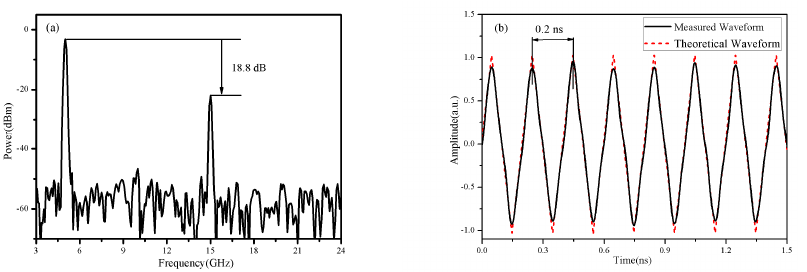
Figure 4. Measured ( a ) electrical power spectrum and ( b ) waveforms of the generated triangular pulse trains with a repetition rate of 5 GHz.